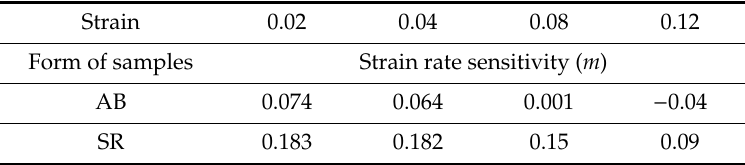
Table 4. Experimental values of relative strain rate